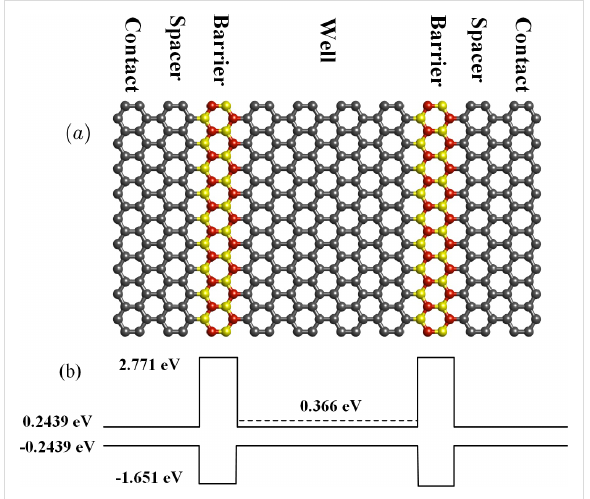
Figure 1: (a) Schematic representation of the proposed RTD. Carbon, boron and nitrogen atoms, are depicted in grey, red and yellow, re- spectively. The contacts are assumed to be heavily doped semi-infi- nite AGNRs. (b) Energy diagram of the proposed RTD (solid lines) and resonant energy of the well (dashed